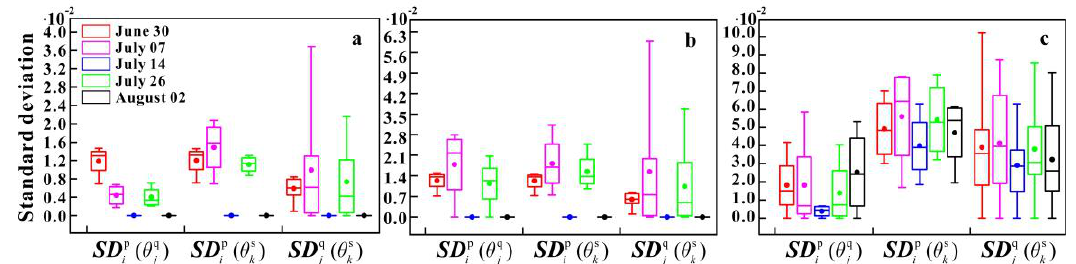
Figure 9. Box plots of the standard deviations based on block kriging ( a ), ordinary kriging ( b ), and simple averaging ( c ) estimations in the smaller scale (SS) pixels within each pixel at the larger scale (LS) on five acquisition days from 30 June to 2 August: SD LS ( θ SS ) (m 3 · m − 3 ). The box boundaries